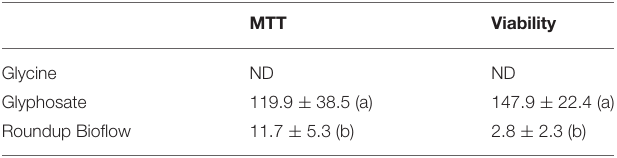
fibroblasts or Caco2 cells. In L929 treatments ( Table 1 )